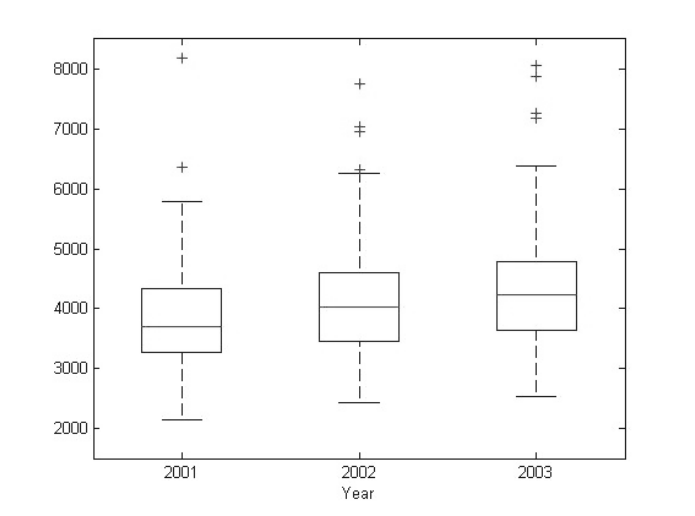
Figure 1 – CPDP summary